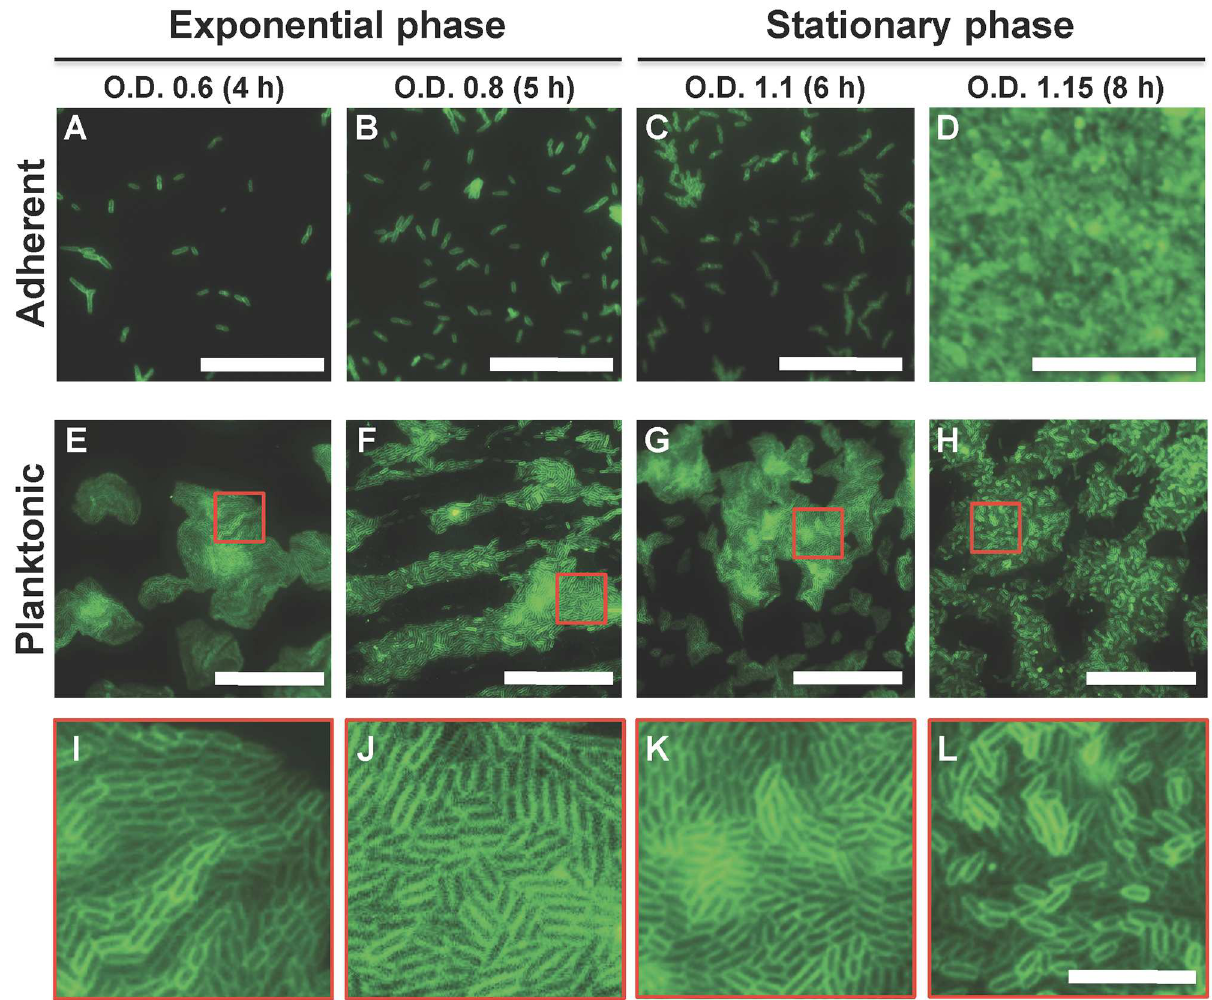
Fig 2. P . stuartii form floating-communities of planktonic-cells prior to adherent biofilms. (A-D) Micrographs of bacteria that remain bound to the well surface, after discardof planktoniccells by PBS washes. (E-H) Micrographs of planktonic bacteria. Cells were pipetted from the LB medium, spreadedon LB-Gelzanand imagedimmediatly. (I-L) Close-upviews of the red-delineated regionsin panels E-H showingclose contact betweenthe membraneof adjacent cells. Bacterial membranes were stained using FM1-43FX. Scale bars: 50 μ m (A-H) and 10 μ m